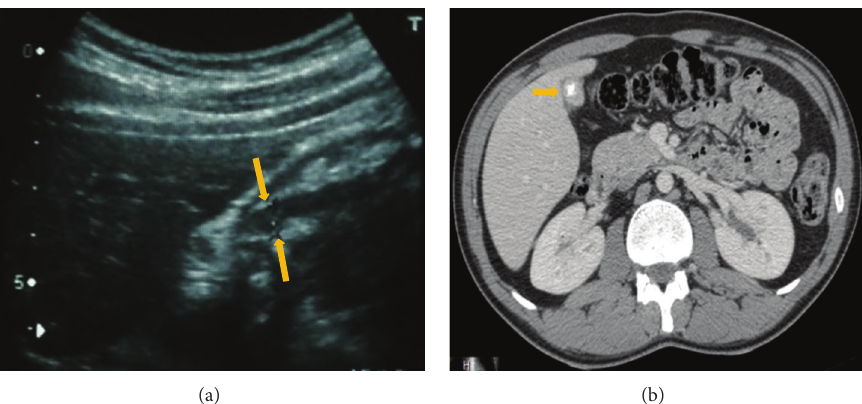
Figure3:Ultrasound(a)andCTscan(b)showingthegallbladderwasretractedwithmicrolithiasisanddiffuseandcircumferentialthickening of its wall.